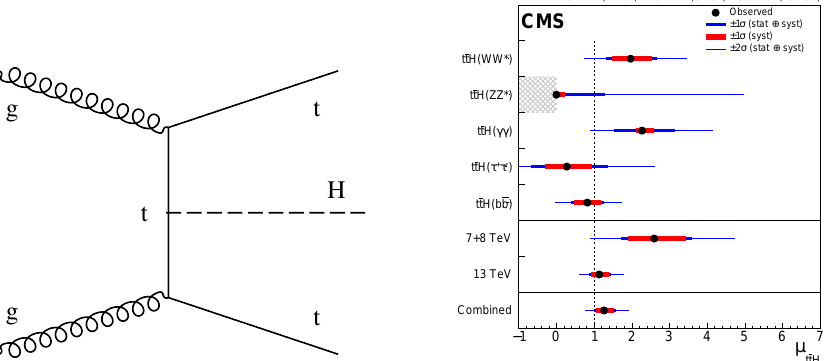
Figure 3. The Feynman diagram of the t¯tH process ( left ) and combination of the measured signal strengths from the different channels of search for the t¯tH process ( right ) [10].